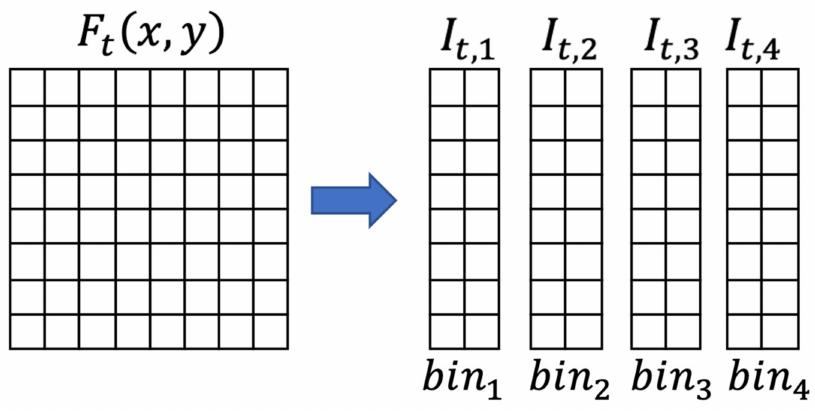
Figure 5. Partitioning a frame into bins.